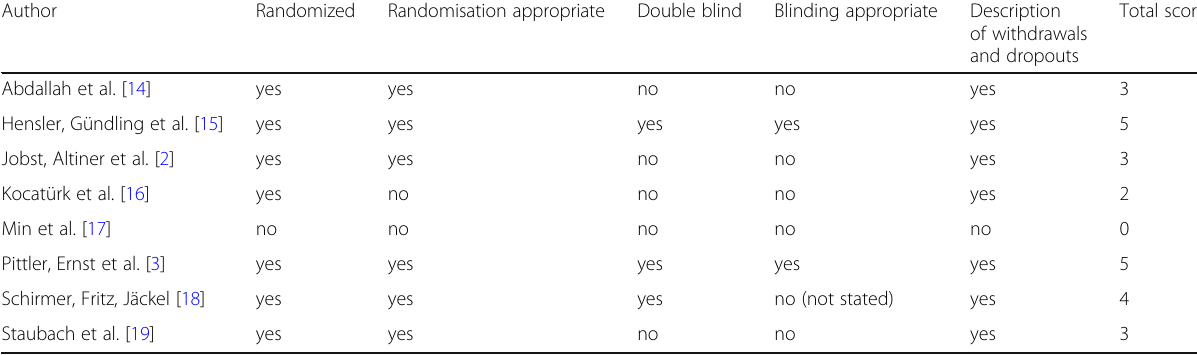
Table 1 Quality assessment controlled clinical trials according to the JADAD Score [13]